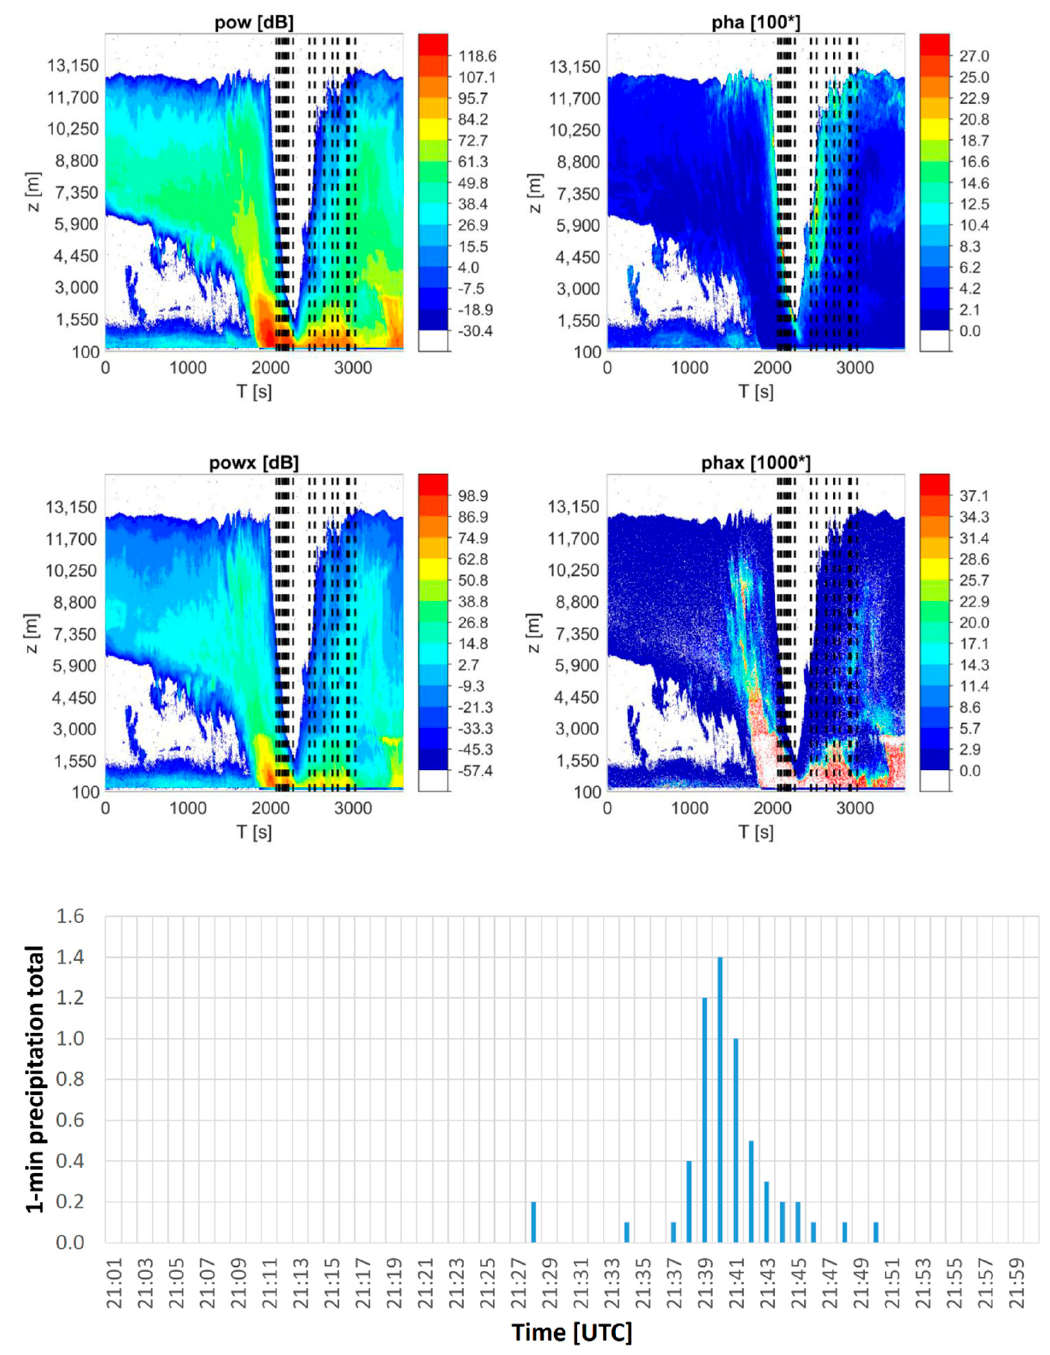
Figure 4. Time evolution of pow, pha, powx and phax (upper two rows) from 21:00 to 22:00 UTC on 10 June 2019. The x-axis shows time (T [s]), while the y-axis displays the height above the radar site (z [m]). Quantities pow and powx are in dB, whereas pha and phax are in arctan of phase degree multiplied by 100 and 1000, respectively. The dashed lines show the time of lightning discharges recorded up to 0.75 km from the radar site. The lower graph shows the 1-min precipitation totals as measured during the same period by the automated weighting rain gauge situated next to the cloud radar.